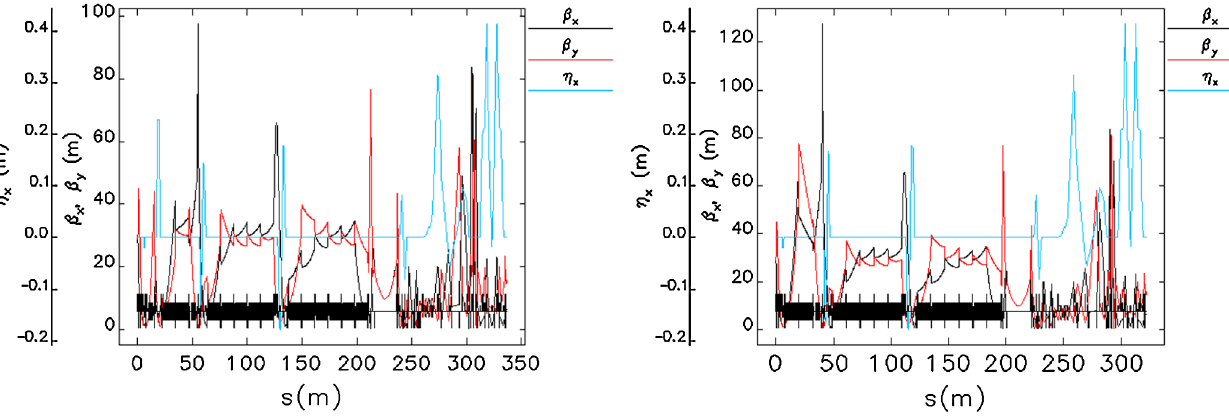
FIG. 2. Layout and optics functions of the NLS linac: (left) the baseline case with three bunch compressors and (right) the case study with two bunch compressors (see text for explanation).